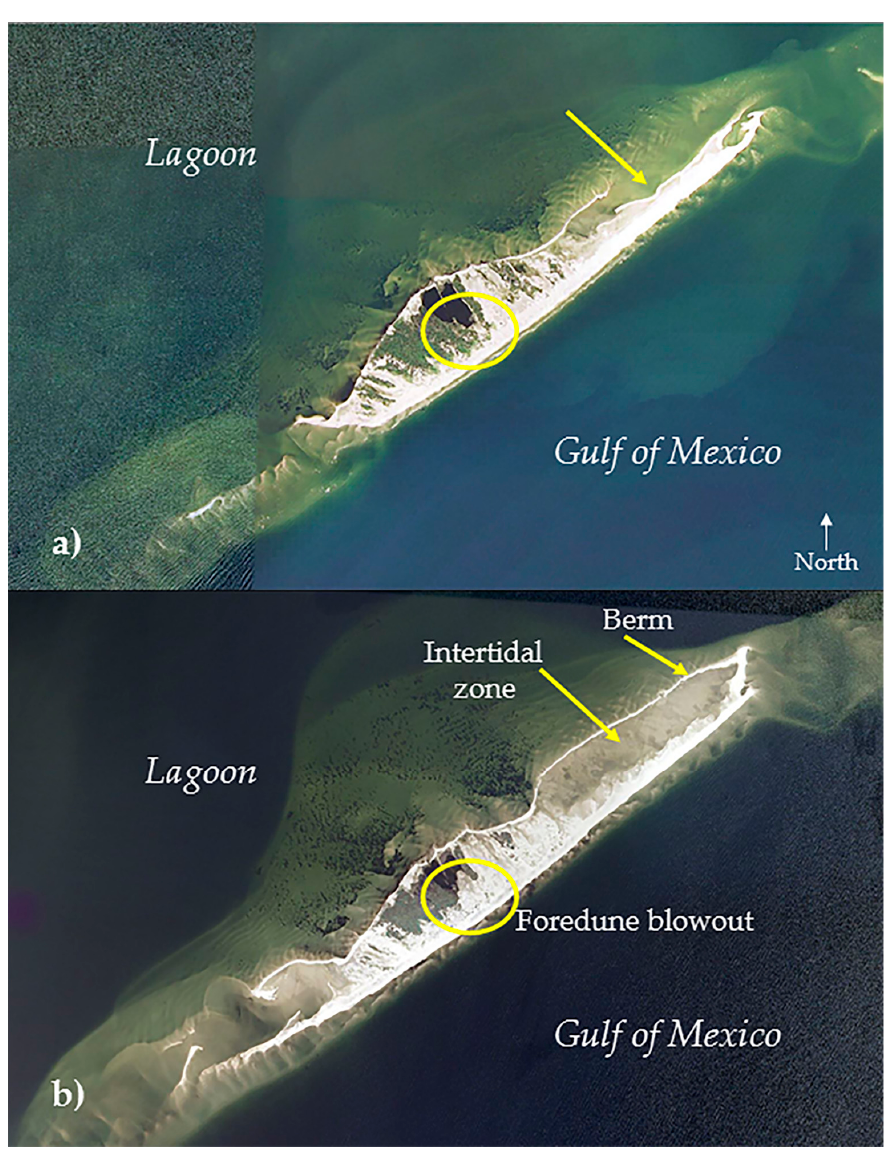
Figure 7. NAIP imagery of East Ship Island from ( a ) 2007 and ( b ) 2009 showing geographic features before and after Hurricane Gustav in 2008. The circled area represents the partial filling of East Ship’s pond due to a foredune blowout. Arrows show an intertidal zone and berm construction.